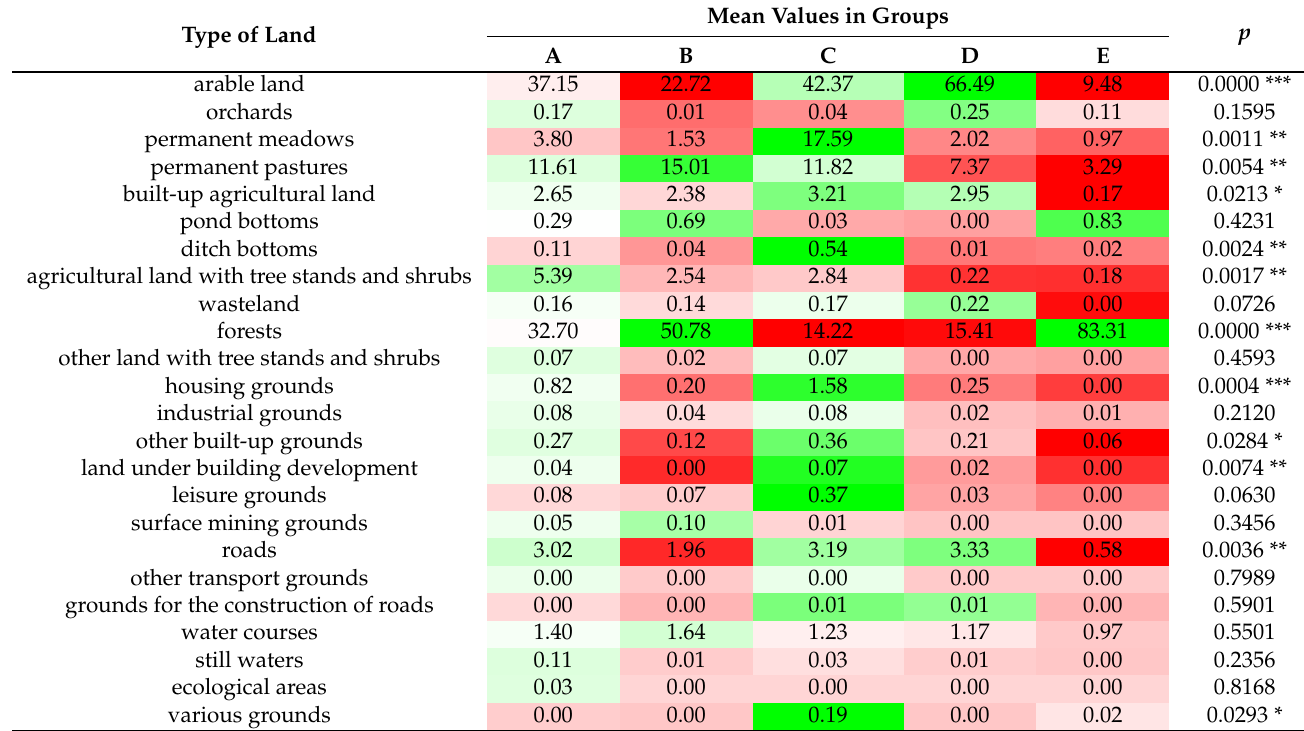
Table 2. Mean values in village clusters identified using Ward’s method.